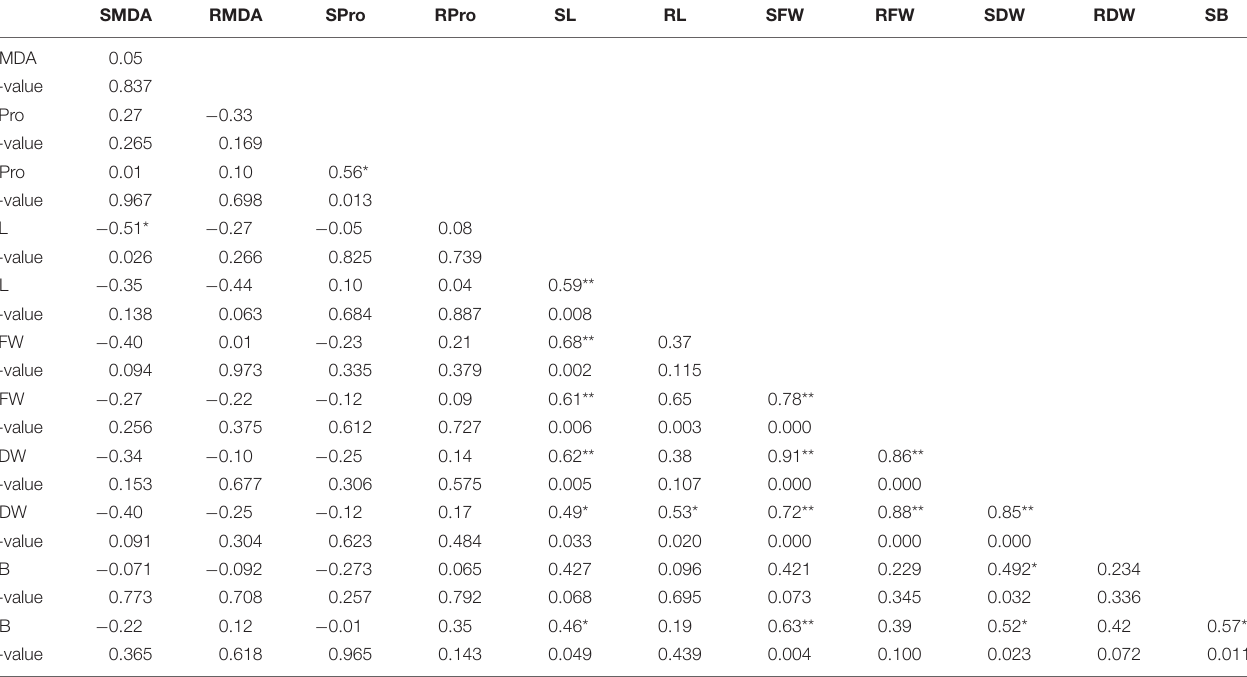
TABLE 4 | Pearson’s correlation and its significance summarizing the association between the percentage changes in the studied parameters under highly toxic B (10 mM B) treatment as compared to Control. SMDA RMDA SPro RPro